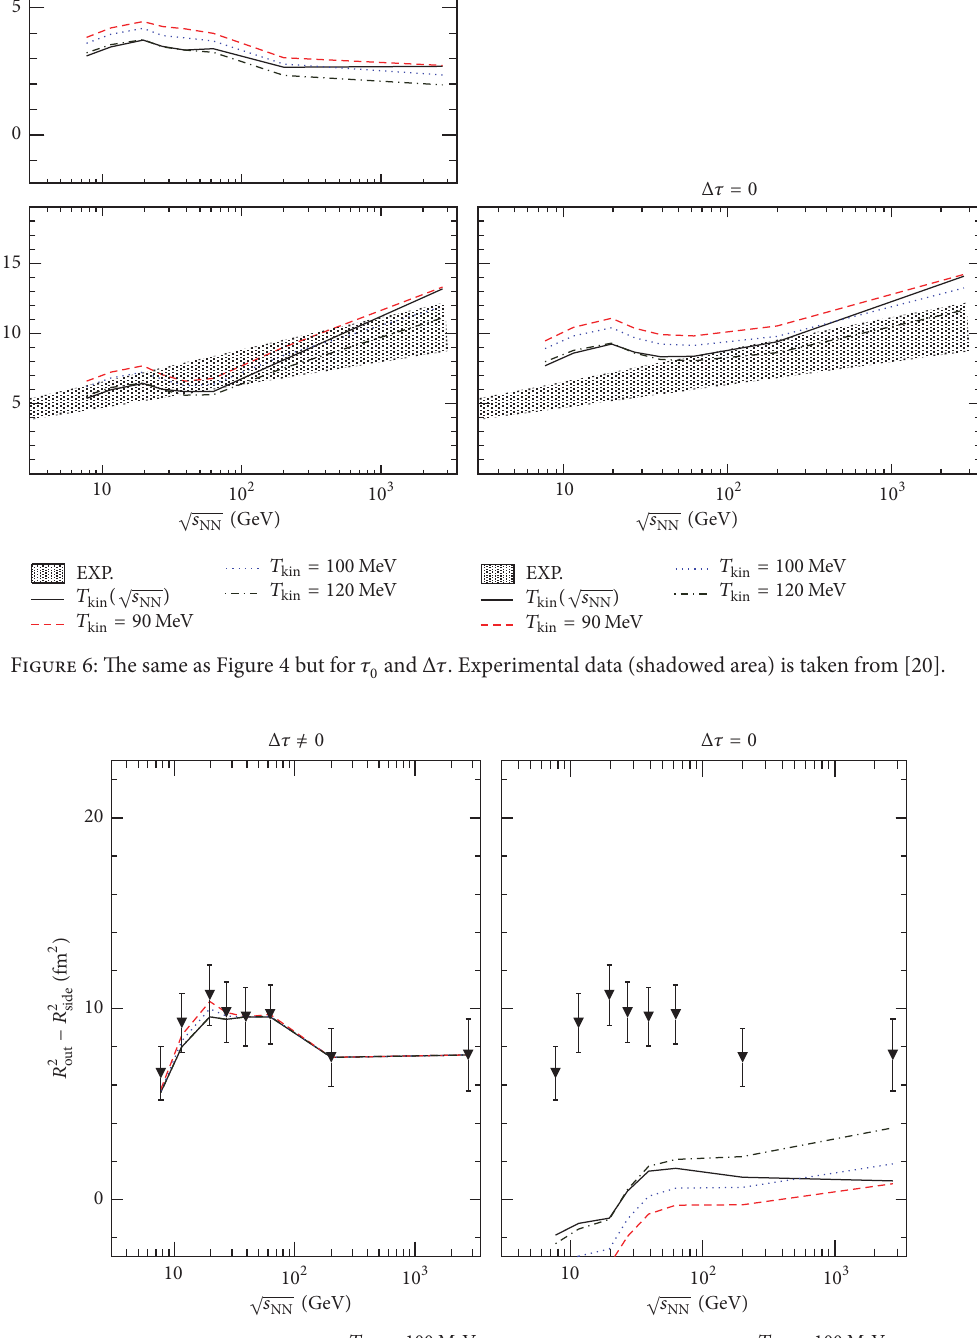
Figure 7: The same as Figure 4 but for the 𝑅 2